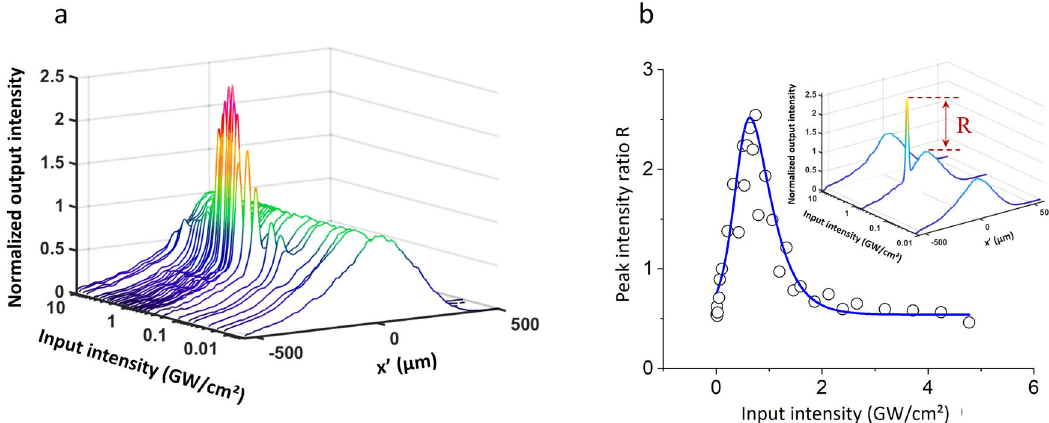
Fig. 3 Fundamental frequency (FF) transverse beam sections at the crystal output. a Twin spotlight beam (TSB) sections of the FF component of the TSB vs. input FF intensity; b peak intensity measuring the intensity elevation of the FF component of the TSB from the local background vs. input FF intensity. R is the peak intensity ratio between the top of the TSB and the encircling background.